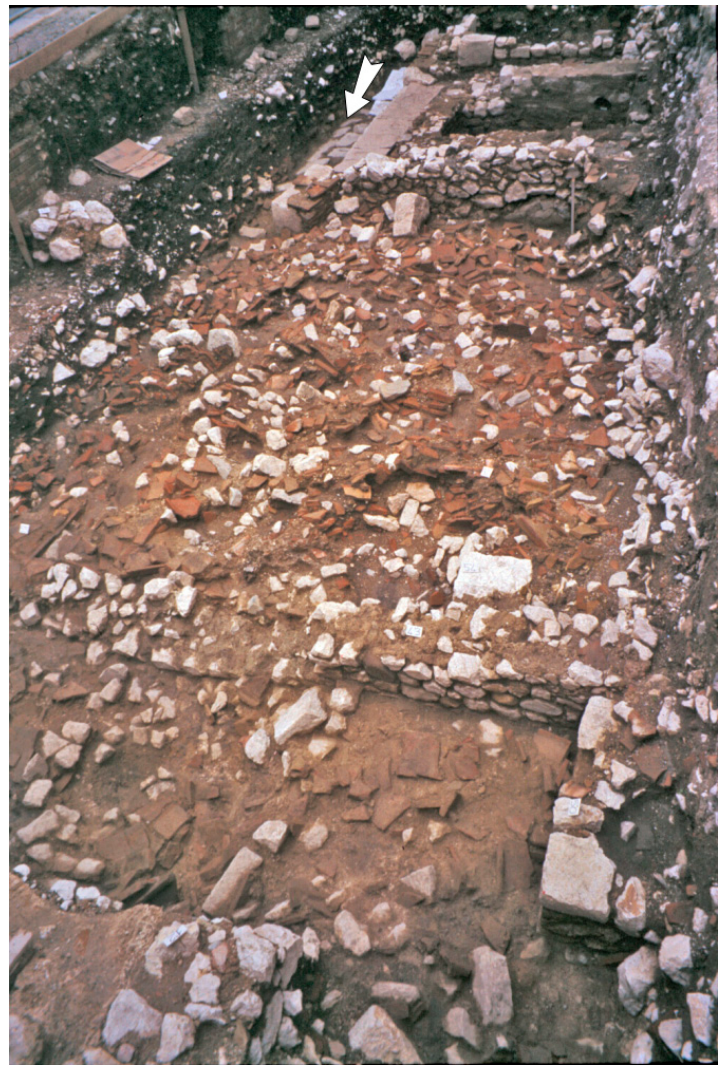
Figure 8. Amendola Square insula. View looking west of the amazing, total, and simultaneous collapse of the porticated house over the Decumanus before the removal of the roof (reddish material). The arrow points to the limestone basoli , where the sheep was found (photo by P.G.).